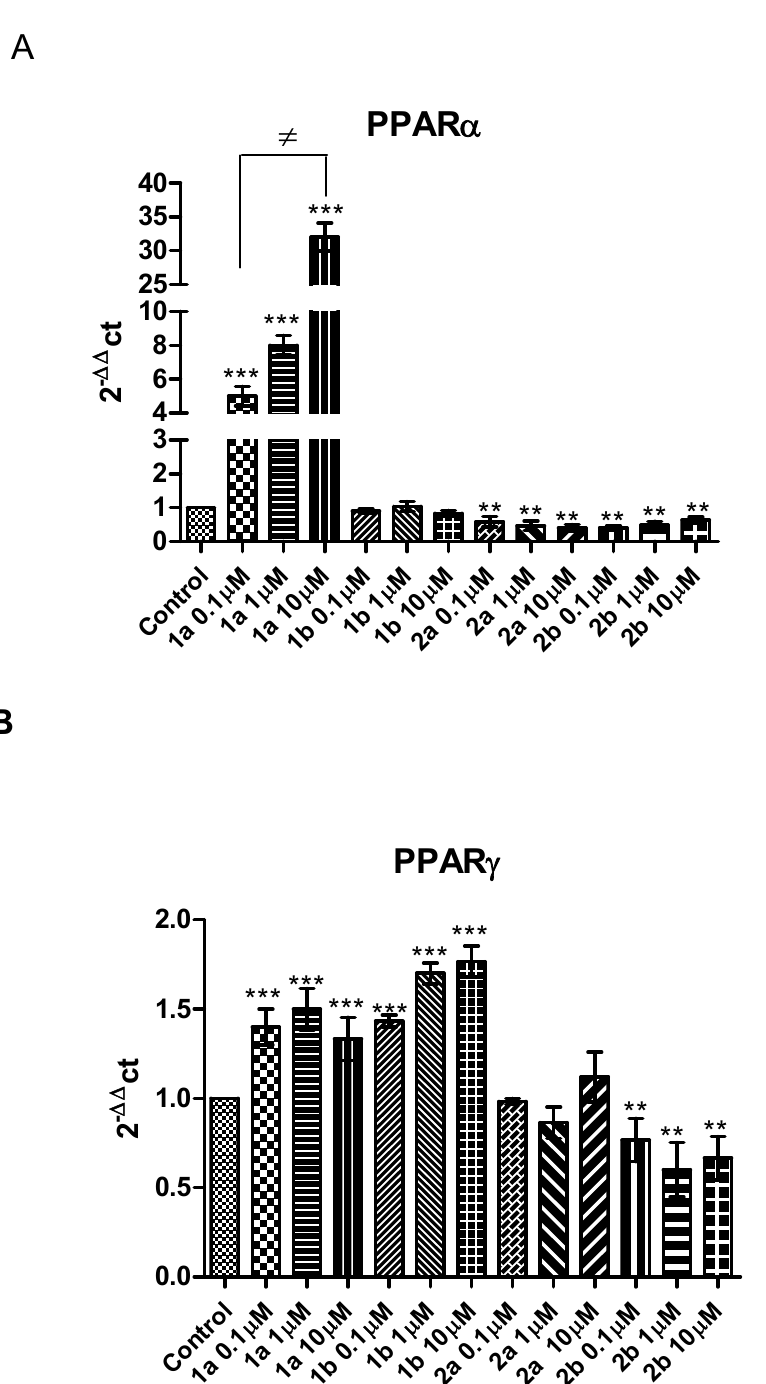
Figure 8. The effects of 1a-b and 2a-b (0.1–10 µ M), on PPAR γ ( A ) and PPAR α ( B ) gene expression in white adipocytes. Data are reported as means ± SEM. The results were analyzed by analysis of variance (ANOVA) followed by the Newman–Keuls post-hoc test. ANOVA, p < 0.0001; post- hoc ** p < 0.01, *** p < 0.001 vs. control group; (cid:54) = p < 0.05 vs. 1a (0.1–1 µ